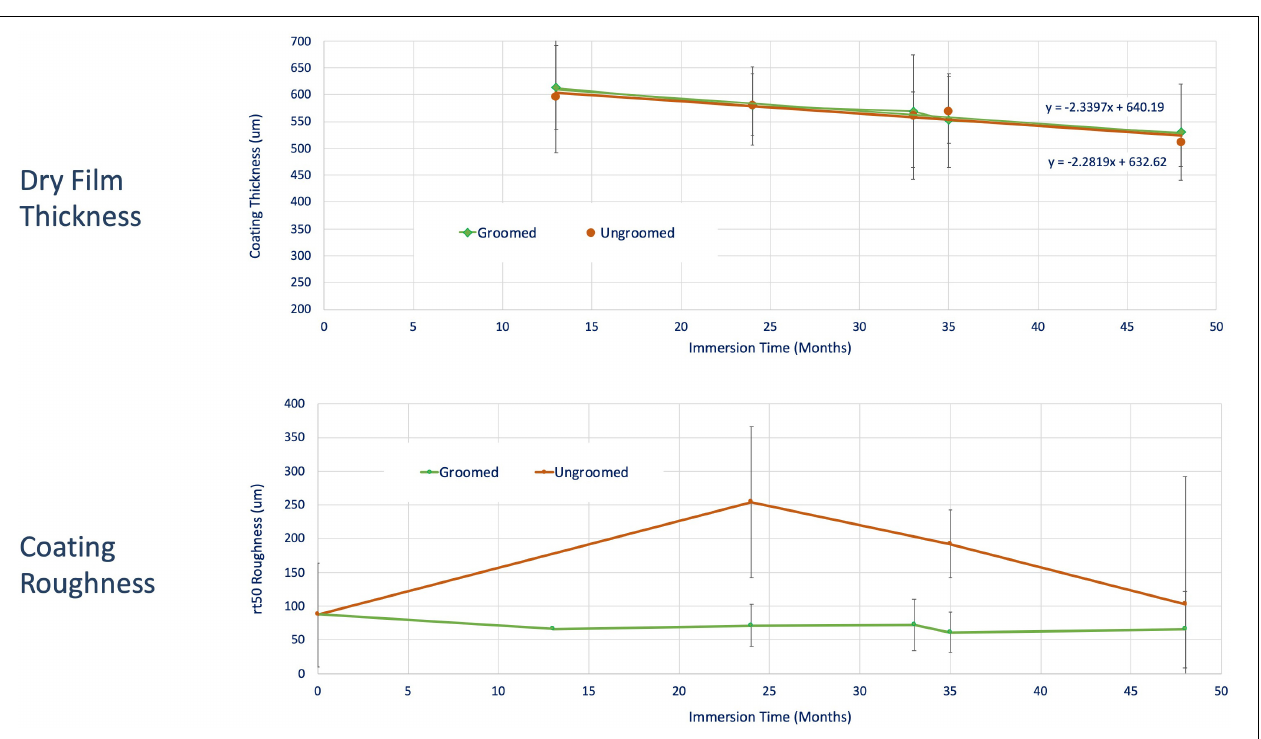
FIGURE 7 | Change in dry film thickness and coating roughness for BRA640 during a 54 months